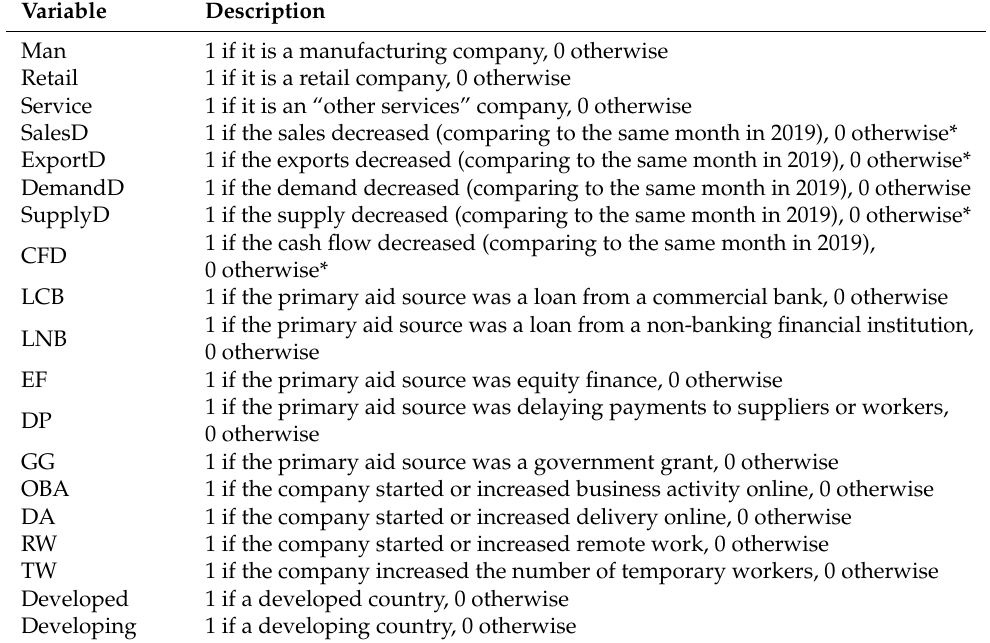
Table 1. Variables used in the